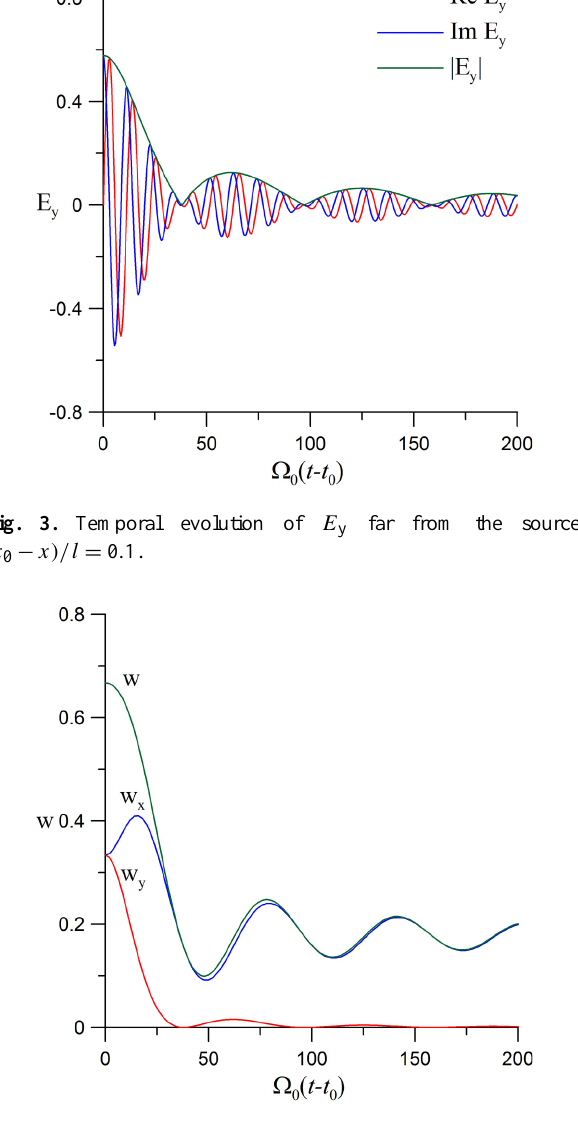
Fig. 4. Temporal evolution of wave energy density, w , and its com- ponents, w x and w y , far from the source, (x 0 − x)/l = 0 . 1.